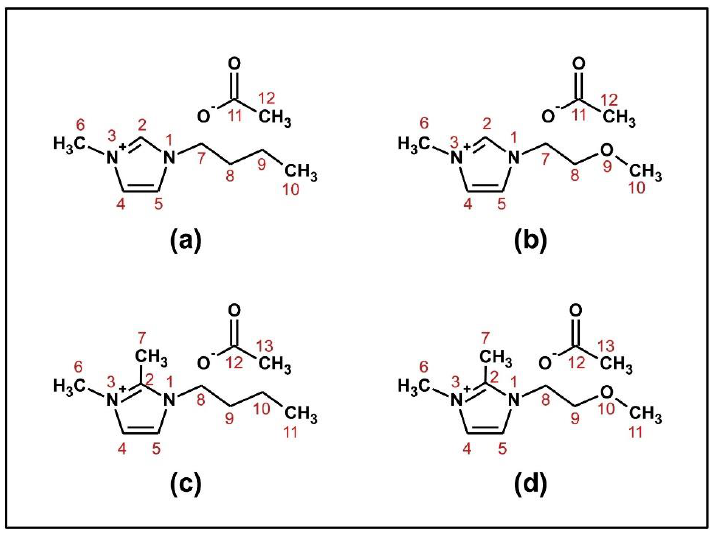
Figure 8. Molecular structures of IL without, and with ether oxygen in their side chains: ( a ) 1-butyl-3-methylimidazolium acetate, ( b ) 1-(2-methoxyethyl)-3-methylimidazolium acetate, ( c ) 1-butyl-2,3-dimethylimidazolium acetate, ( d ) 1-(2-methoxyethyl)-2,3-dimethylimidazolium acetate; reproduced from [74], with permission from Elsevier,2019. The lower efficiency of PrOMeImAcO was attributed to simultaneous “deactivation” of the ether oxygen (Lewis base) and C 2 - H (Lewis acid) of the imidazolium ring due to intramolecular hydrogen bonding, as shown in Figure 9, based on MD calculations [75].